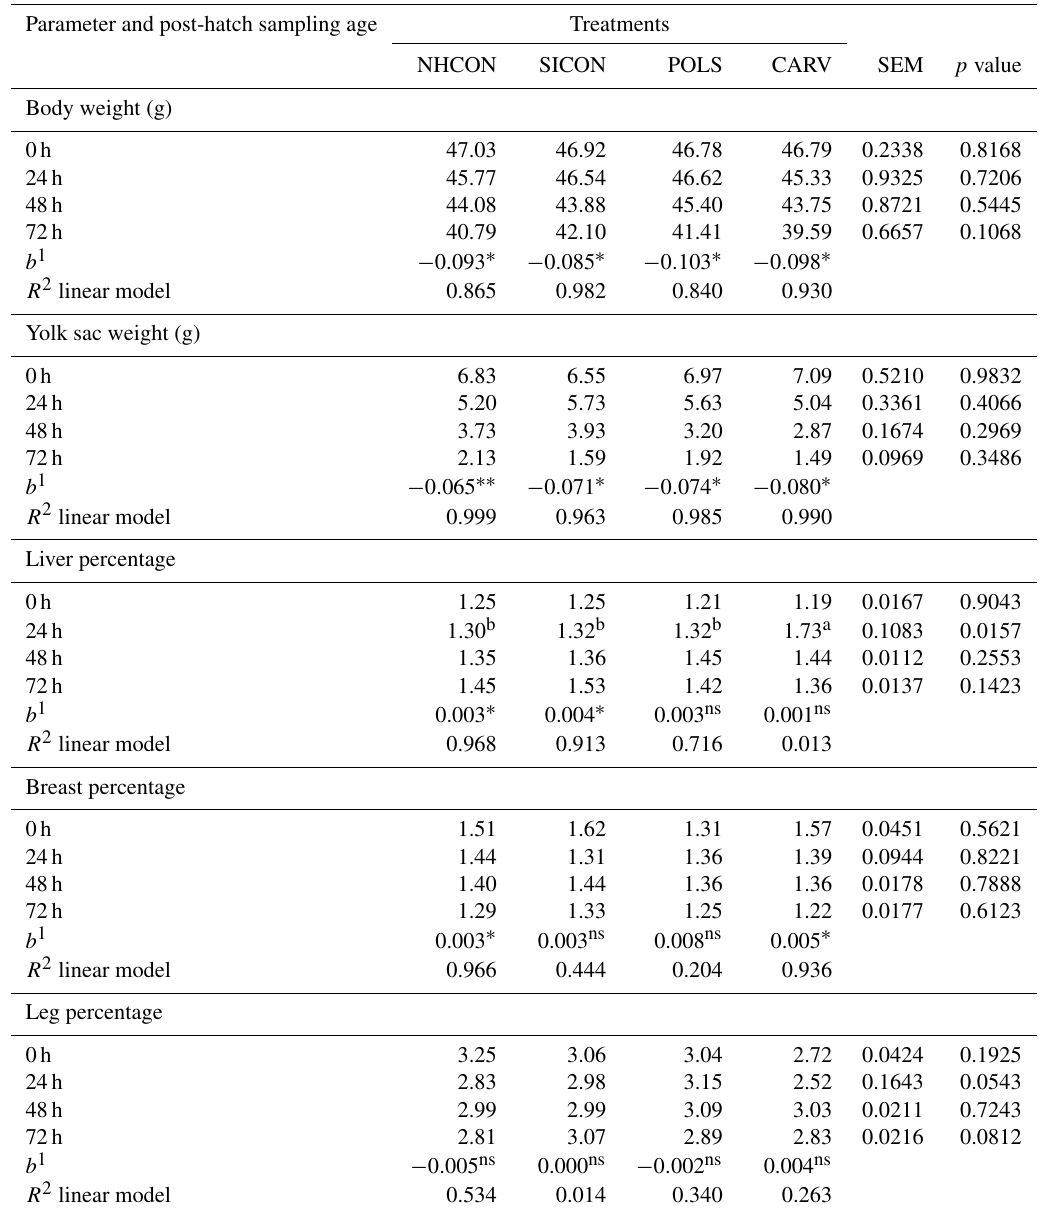
Table 2. Body weight, yolk sac weight, and liver, breast, and leg percentage (total body weight) in chicks subjected to experimental treat- ments, namely non-handled control (NHCON), sham injection control (SICON), polysorbate-80 injection (POLS), and carvacrol injection (CARV), in post-hatch sampling